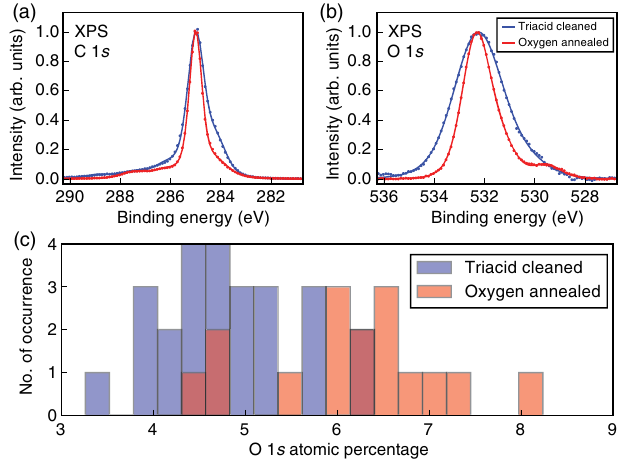
FIG. 15. (a),(b) Comparison of high-resolution XPS spectra at carbon 1 s and oxygen 1 s peaks from triacid-cleaned and oxygen- annealed surfaces. The linewidths are narrower for the oxygen- annealed surface. (c) Histogram of the oxygen 1 s atomic percentage from the XPS signal, obtained from a large number of triacid-cleaned and oxygen-annealed atoms on the diamond surface to be 7.6%. Figure 15(c) shows a histogram of the measured oxygen 1 s atomic percentage from multiple XPS spectra, where the oxygen- annealed surfaces show markedly higher oxygen 1 s per- centage compared to the triacid-cleaned surfaces. The values obtained are consistent with an oxygen monolayer on the surface after oxygen annealing, while the triacid- cleaned surfaces have lower oxygen coverage, indicating incomplete oxygen termination.